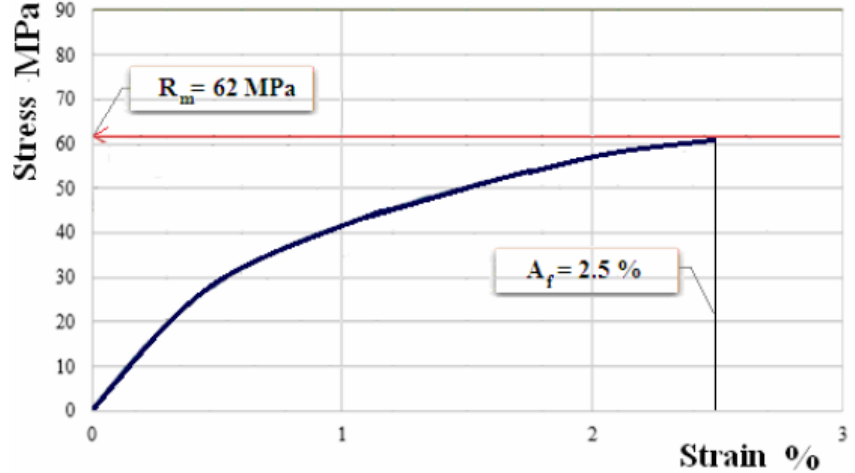
Figure 12. Characteristic curve for sample of composite material with matrix of hybrid resin of type 3, reinforced with the second type of fabric.